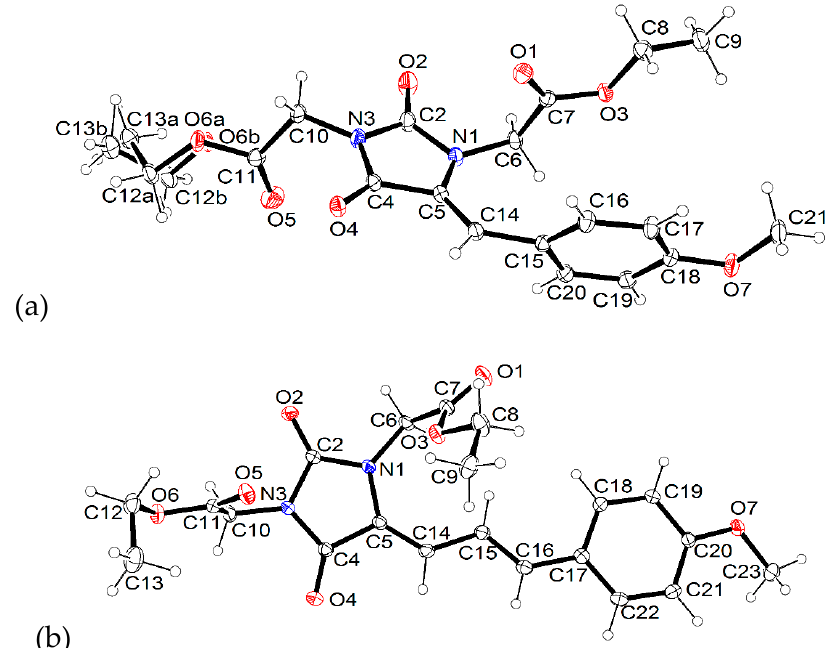
Figure 2. The molecular geometries of ( a ) 3b and ( b ) 4g , with the atom numbering schemes. Displacement ellipsoids are drawn at the 30% probability level.